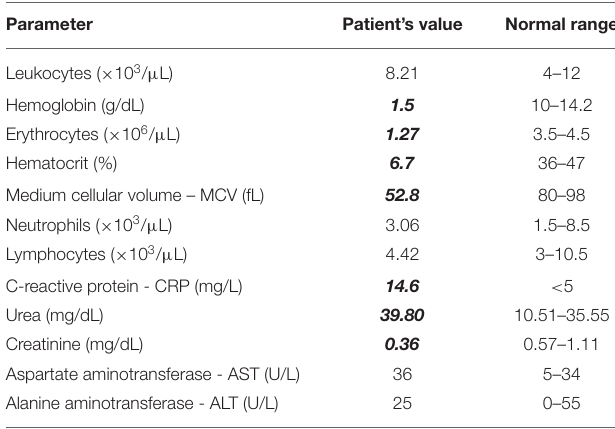
TABLE 1 | Blood parameters are indicators of severe anemia, undernourishment and